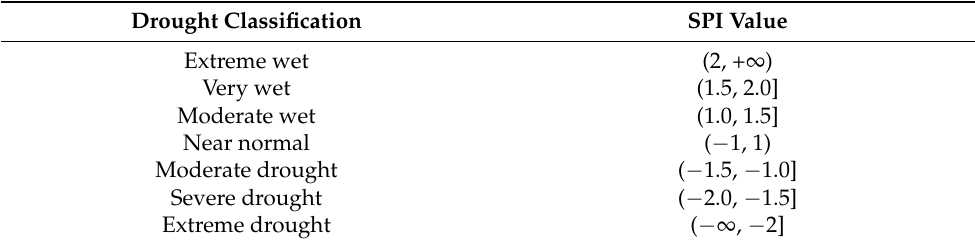
Table 2. Categories of drought calculated by the SPI. Drought Classification